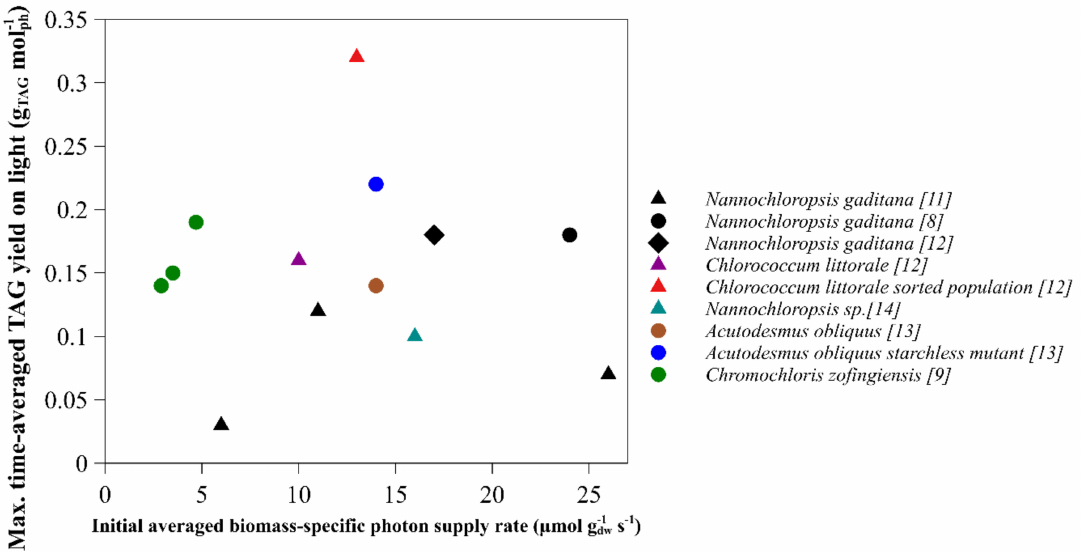
Figure 3. Maximal time-average TAG yield on light comparison for various microalgal species under various initial biomass-specific photon supply rates. The light regime used: continuous (circles), sinus (triangles) and block (diamonds). The yield for Chromochloris zofingiensis was calculated based on absorbed light. Details of the calculated biomass-specific photon supply rates from different studies are shown in Table A1